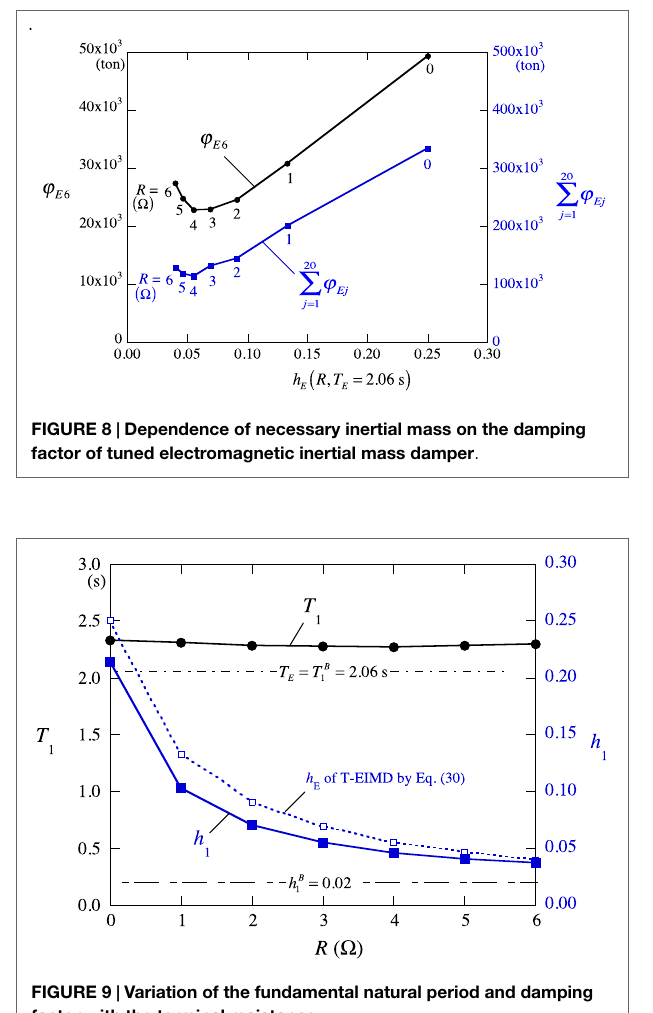
FIGURE 9 | Variation of the fundamental natural period and damping factor with the terminal resistance .